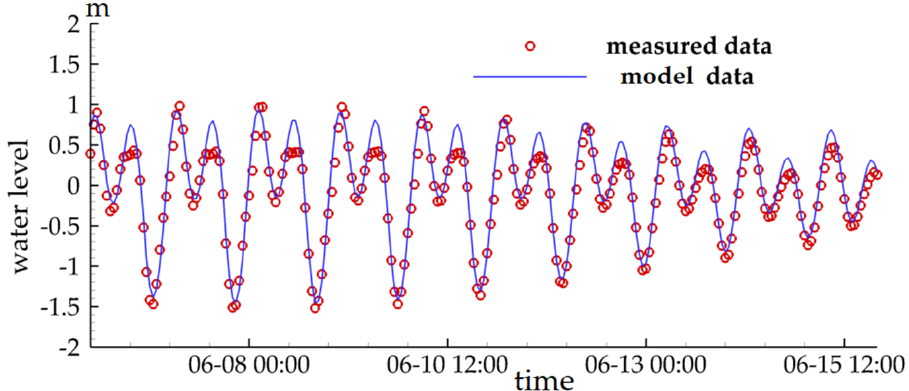
Figure 8. Tidal constituent verification for M2, S2, K1, O1, and P1.